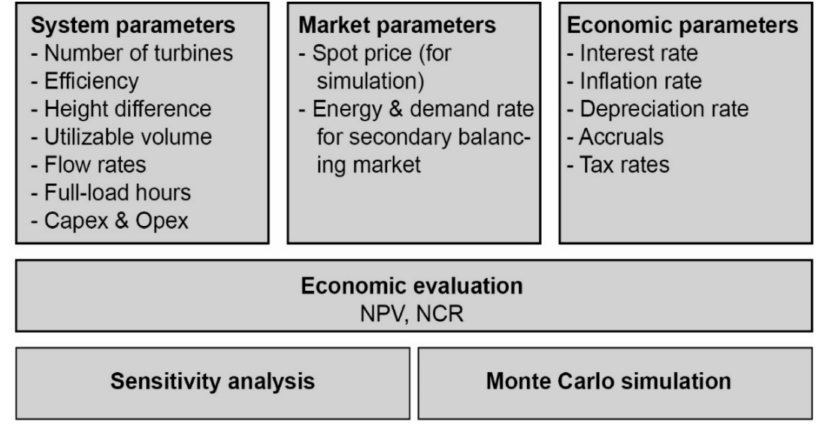
Figure 6. Overview of the economic model.